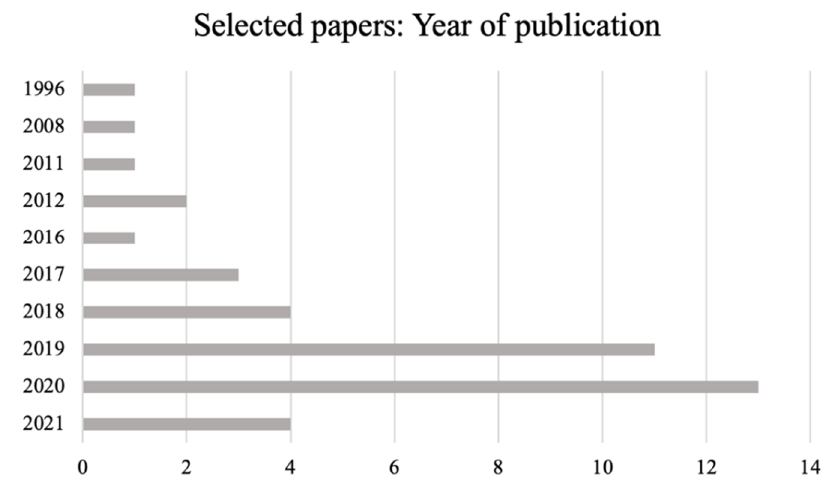
Figure 5. Year of publication of the selected papers.